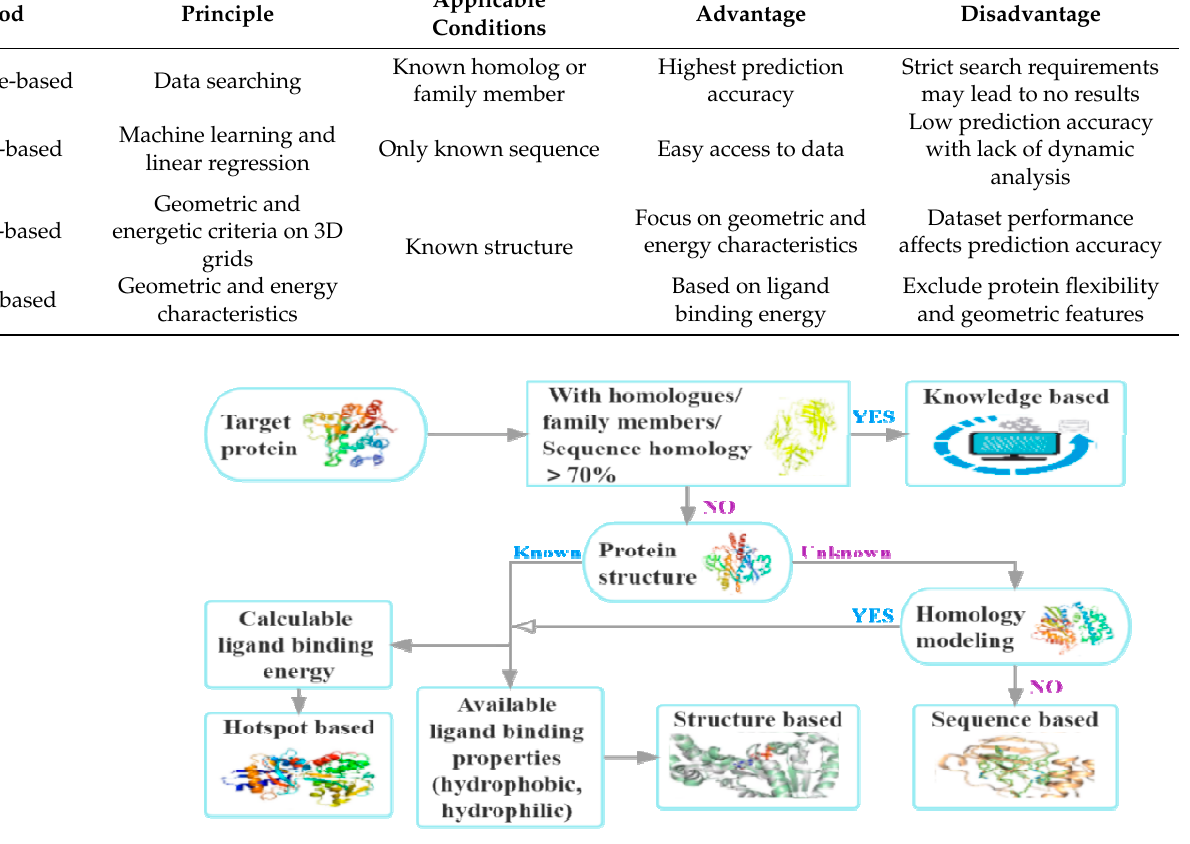
Figure 6. Process for choosing appropriate druggability evaluation methods.